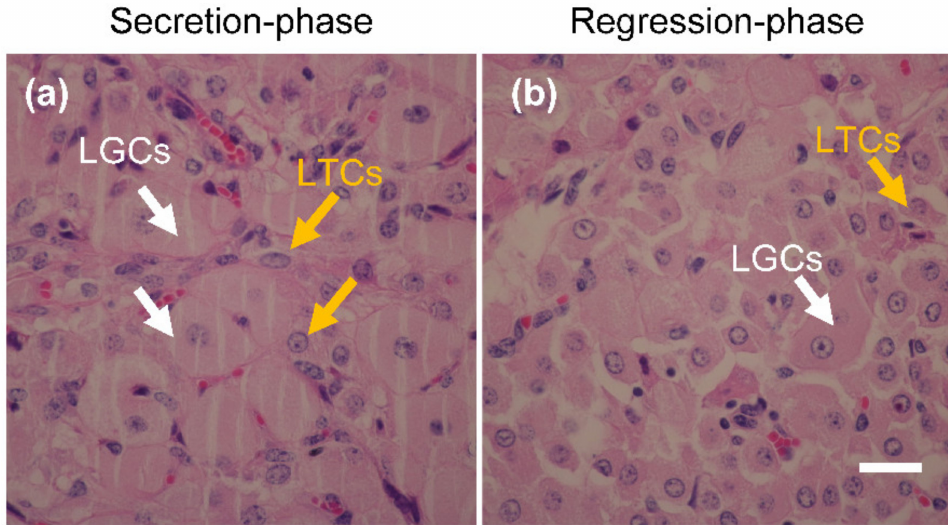
Figure 2. Histological images of bovine corpus luteum (CL) section. The CL sections were stained using Eosin-Y and hematoxylin method, secretion-( a ) and regression ( b )-phases CL were isolated from heifer. White bar: 25 µ